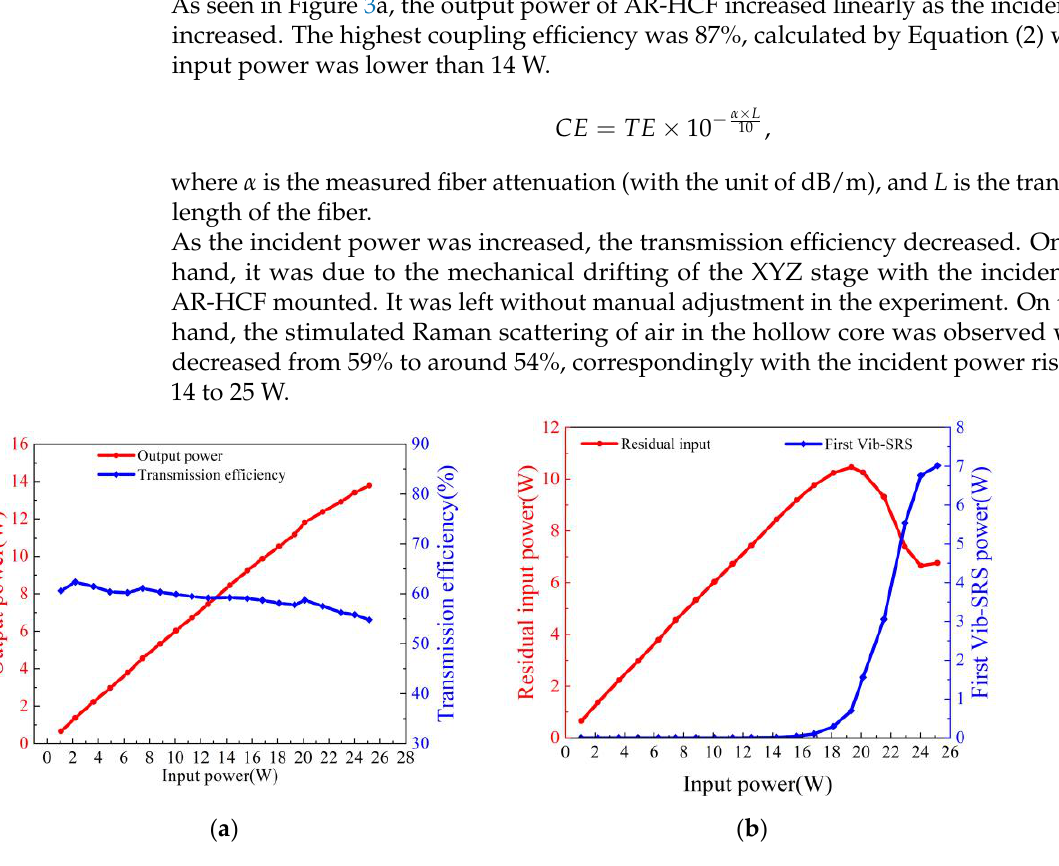
Figure 3. ( a ) Measured output power and transmission efficiency as a function of incident power and ( b ) Measured powers of the residual incident and first Vib-SRS as a function of input power. The measured output spectra at the output of AR-HCF are shown in Figure 4. A peak centered at 1414 nm appeared in the output spectrum at input peak power above 3.6